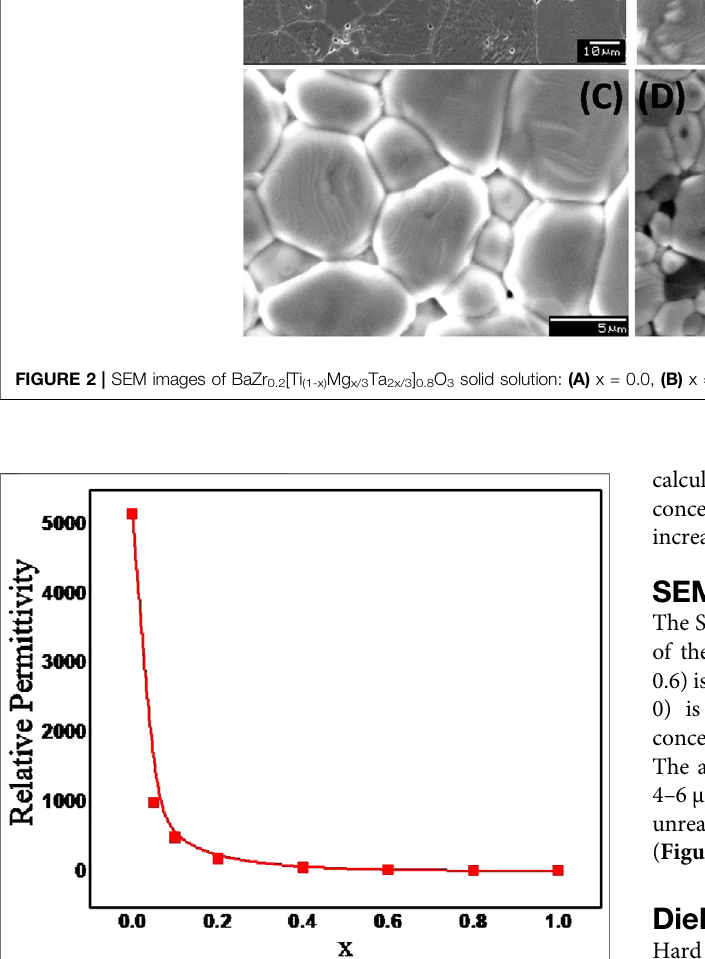
FIGURE 3 | Variation of Relative permittivity of BaZr 0.2 [Ti (1-x) Mg x/3 Ta 2x/3 ] 0.8 O 3 with x at 1